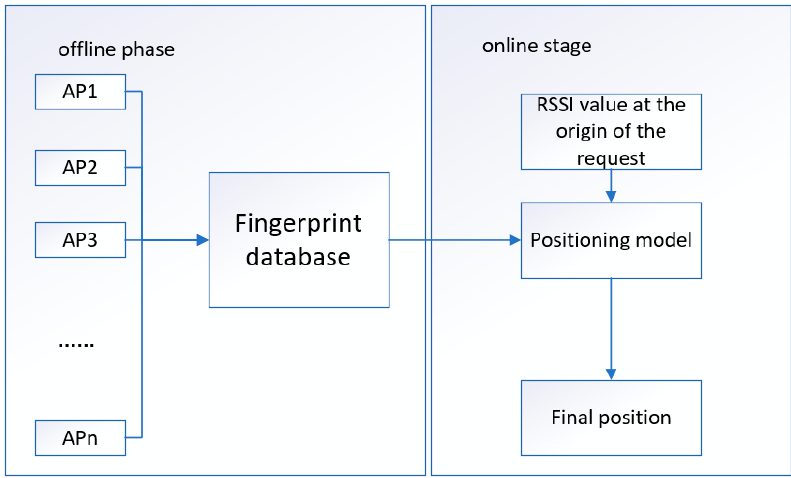
Figure 1. Fingerprint-based WiFi indoor positioning system architecture.